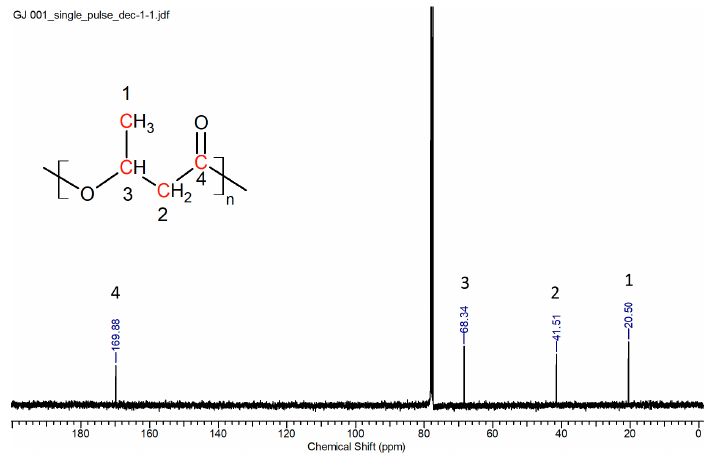
Figure 2. 13 C NMR spectrum of the PHA extracted using chloroform.